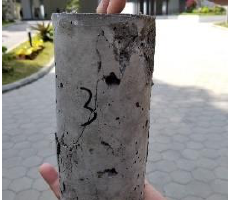
Figure 2. Data augmentation using rotation.